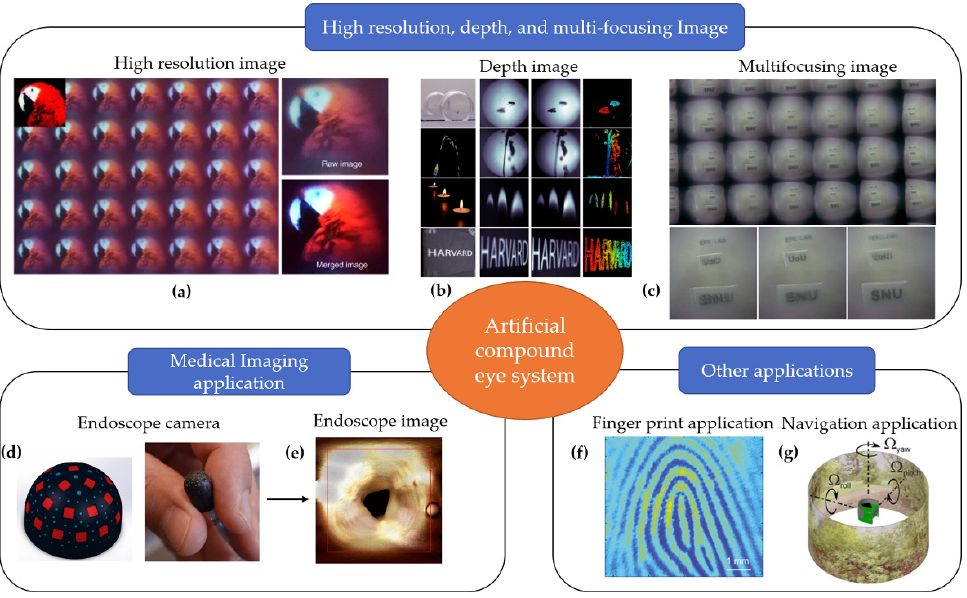
Figure 22 . The applications of artificial compound eye systems. ( a ) The high resolution image. Reproduced from [40]. CC by 4.0. ( b ) The depth image. Adapted from [73]. CC by 4.0. ( c ) The multifocusing image. Reprinted from [5]. CC by 4.0. ( d , e ) The medical imaging application. Reproduced from [74] with permission from IEEE Publishing. ( f ) The biometric finger print capturing application. Adapted from [75]. CC by 4.0. ( g ) The navigation application. Reprinted with permission from [76] © (2014) Copyright Society of Photo-Optical Instrumentation